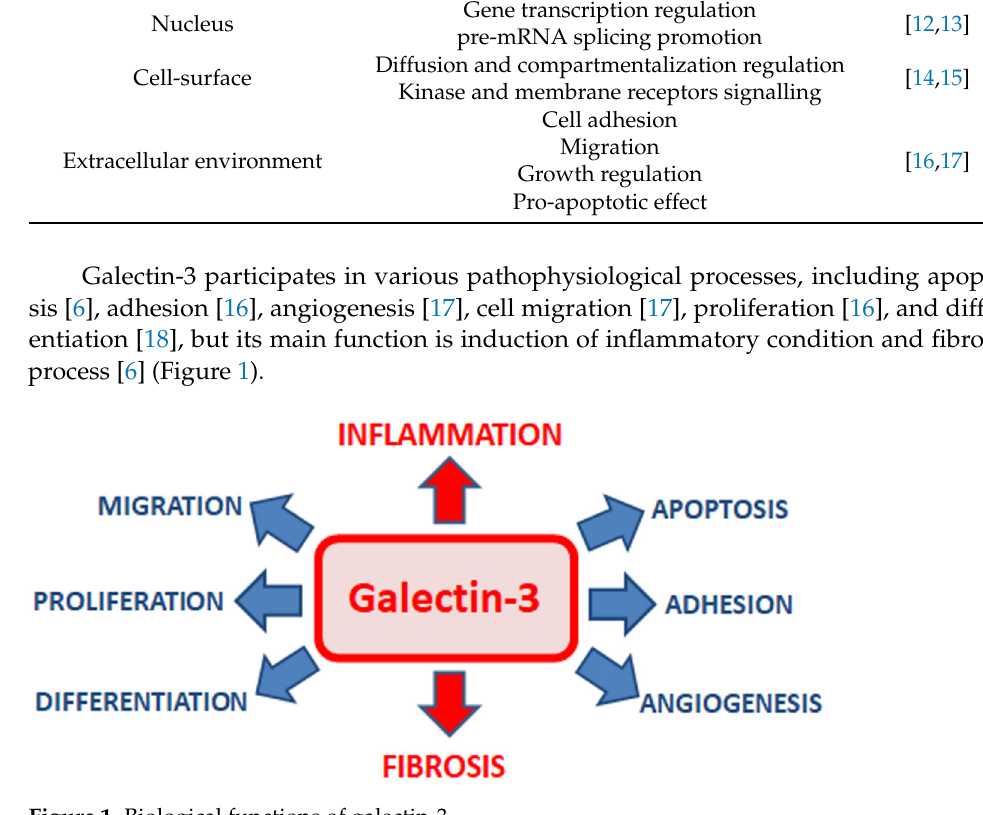
Figure 1. Biological functions of galectin-3.